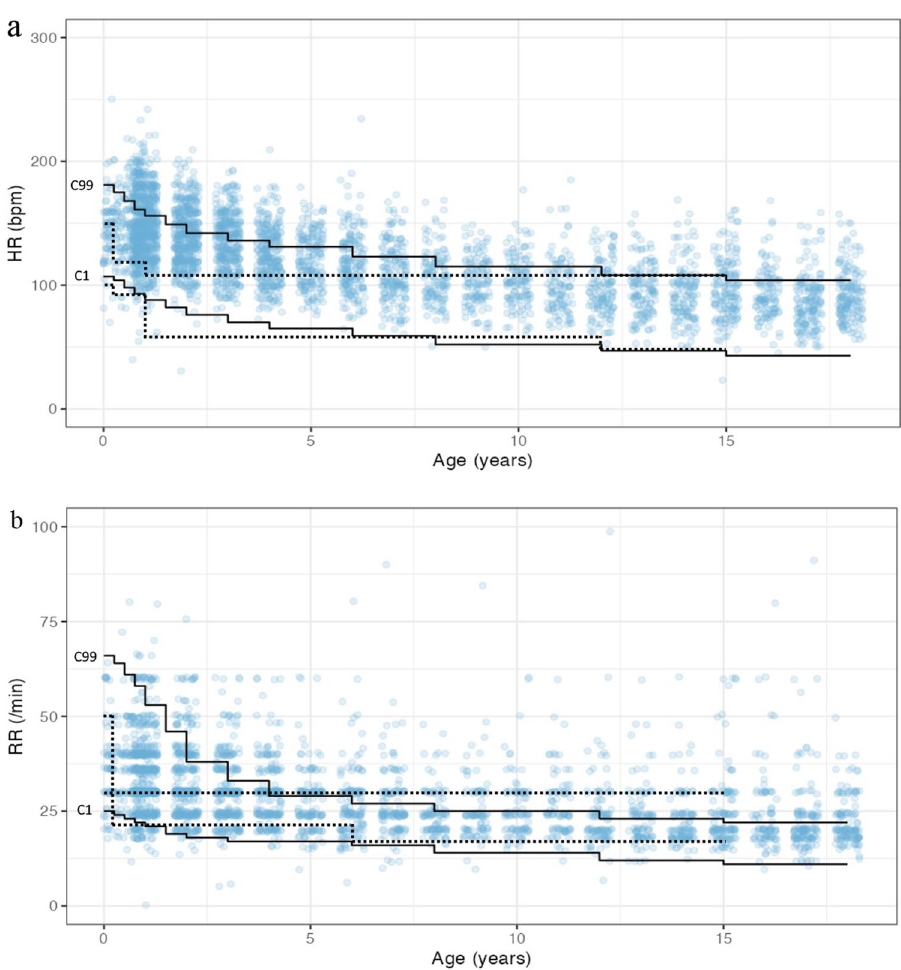
Figure 2. Centile curves of the heart rates ( a ) and respiratory rates ( b ) of healthy children as developed by Fleming et al. 1 (solid lines), reference ranges of the triage scale of the Kobe City Emergency Transport System (dotted lines), and plots of the study population. C1, the 1st centile; C99, the 99th